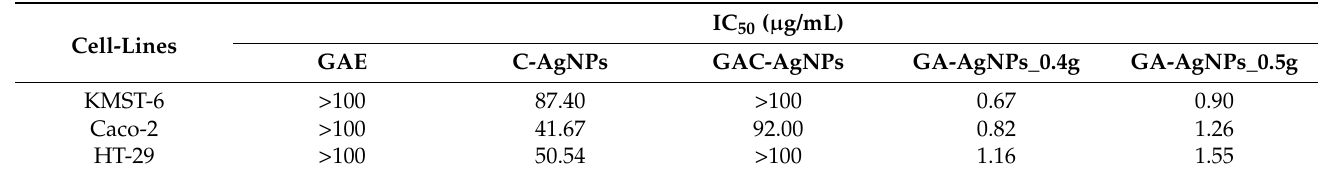
Table 6. The IC 50 values of treatments against different cell